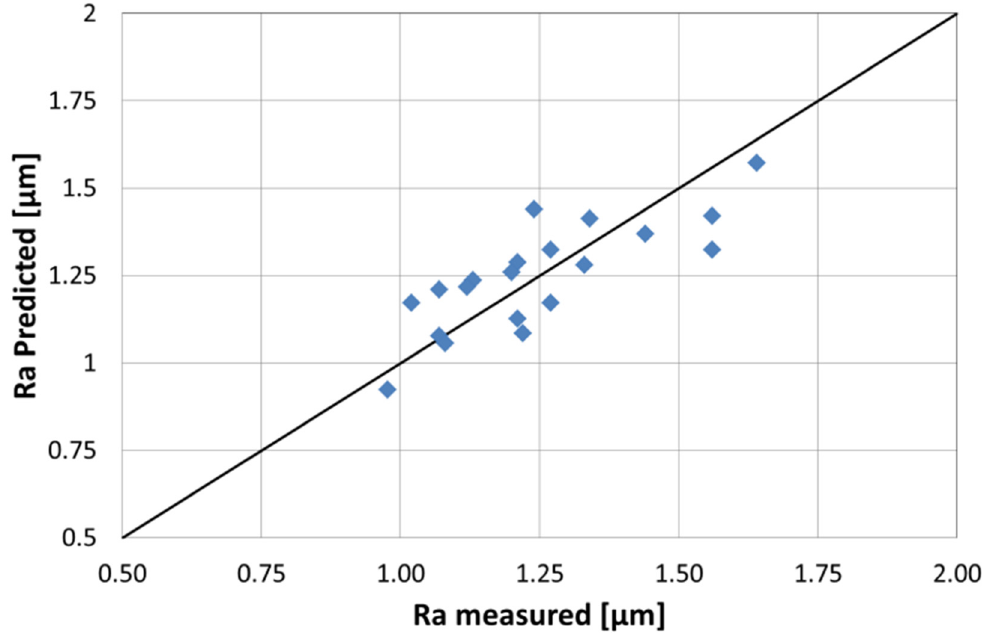
Figure 6. Predicted Ra vs. measured Ra for the first DoE model.